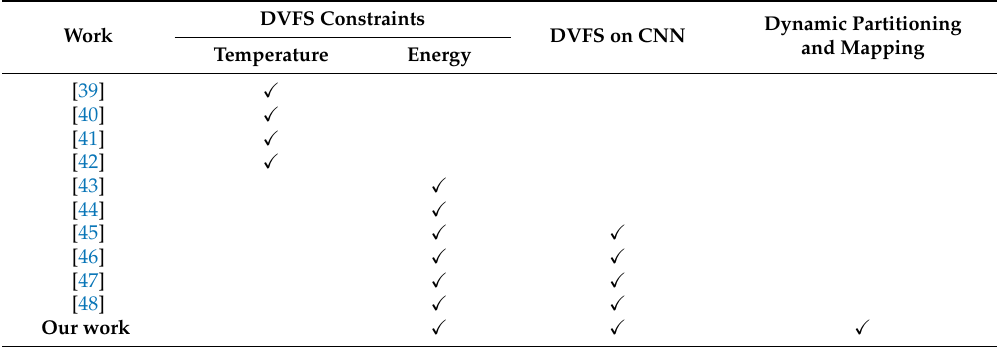
Table 2. Qualitative comparison with dynamic voltage and frequency scaling, especially in CNN- based designs